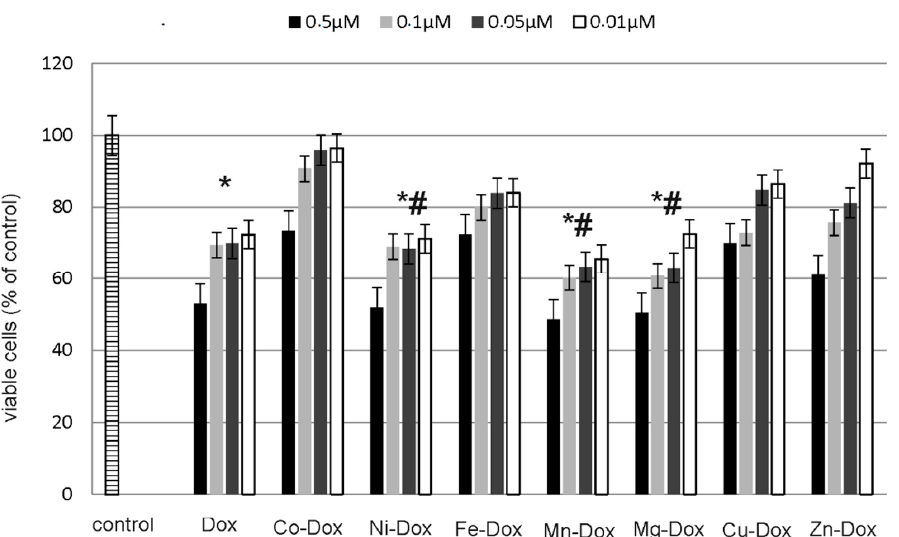
Figure 8. The effect of DOX, Cu-DOX, Zn-DOX, Co-DOX, Ni-DOX, Fe-DOX, Mn-DOX and Mg-DOX on cell viability of MCF-7 cells. The cells were incubated with 0.5 µM, 0.1 µM, 0.05 µM and 0.01 µM DOX and Metal-DOX complexes for 24 h. Mean values from five independent experiments ± SD are shown. Significant alterations are expressed relative to control untreated cells (marked with asterisks *) and to DOX—controls (marked with crosses #). Statistical significance was considered if *# p < 0.05.